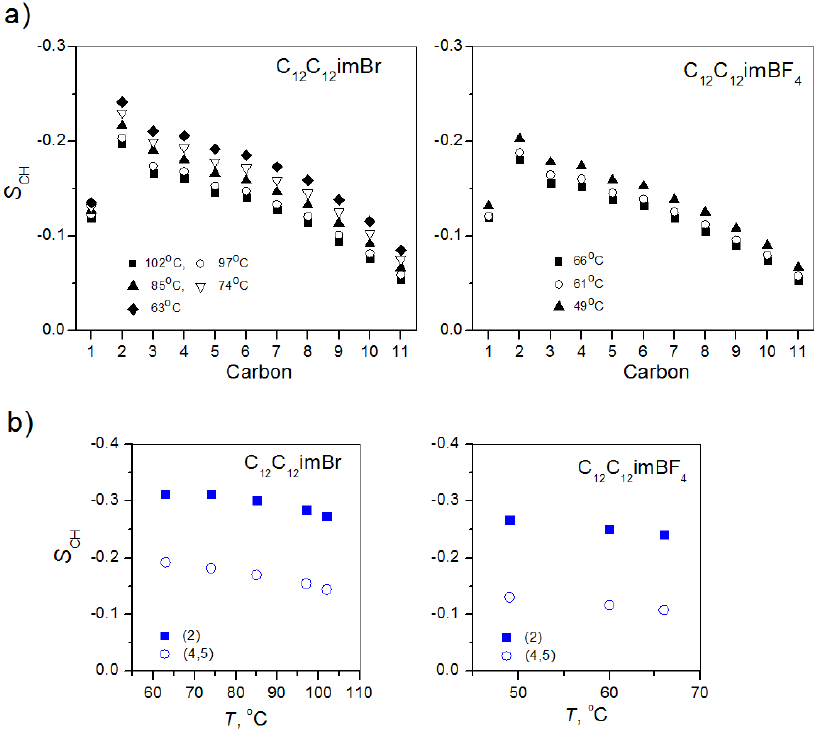
Figure 5. ( a ) Bond order parameter profiles of C 12 C 12 imBr ( left ) and C 12 C 12 imBF 4 ( right ) in smectic A phase at different temperatures. ( b ) Temperature dependence of the C ‐ H bond order parameter of imidazolium carbons in C 12 C 12 imBr ( left ) and C 12 C 12 imBF 4 ( right ). Bond order parameters are presented in the director reference frame.